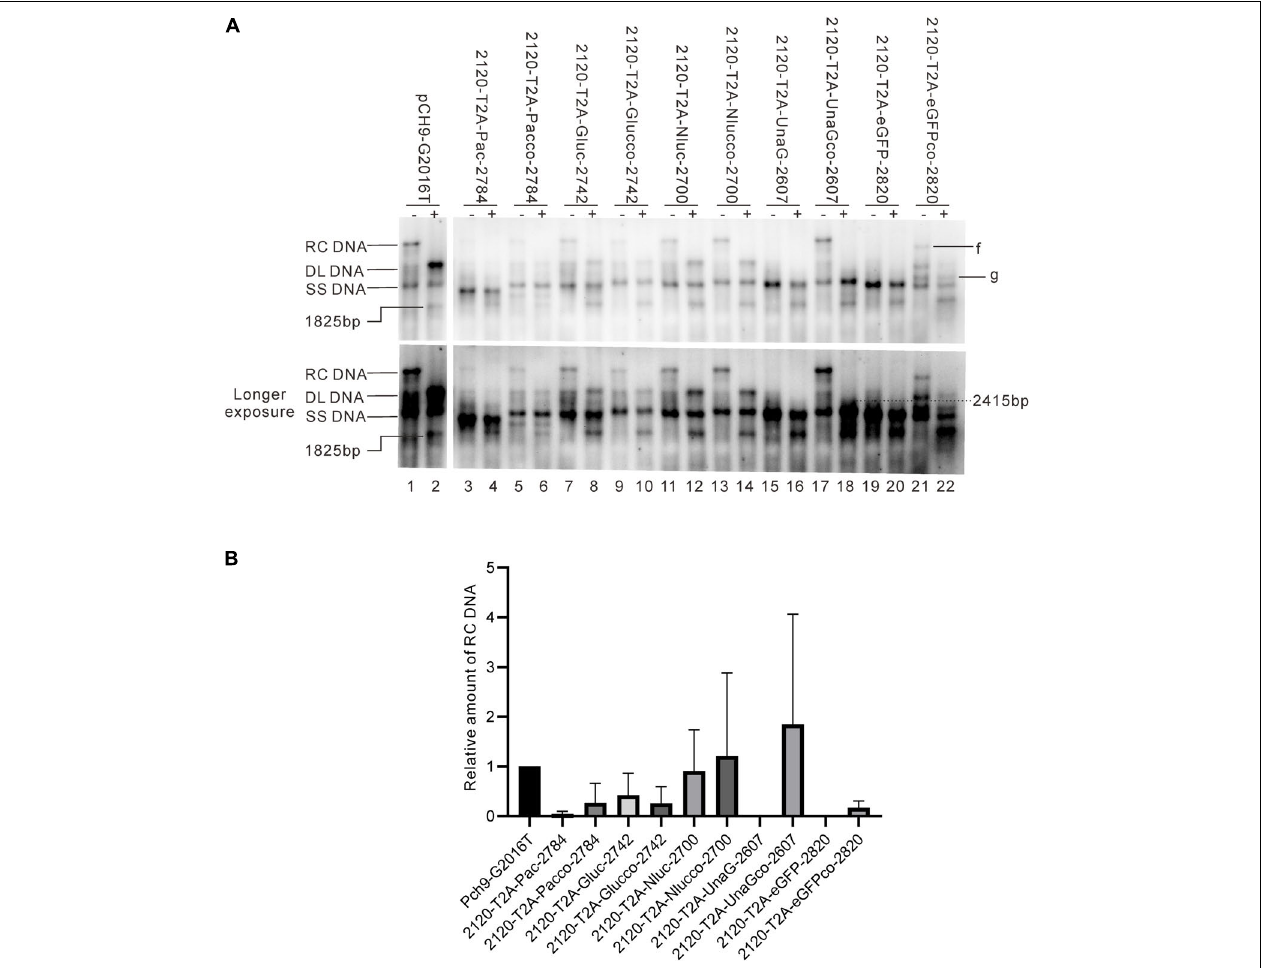
FIGURE 9 | Influence of sequence optimization of exogenous genes on HBV replication. (A) A comparison of HBV DNA from the recombinants before and after sequence optimization. The plus sign (+) denotes Eco RI digestion. RC, DL, SS DNA, and Eco RI digested fragments are indicated. (B) The relative intensity of RC DNA. The intensity of each RC DNA was divided into the sum of RC DNA of all samples in the same membrane to calculate the relative intensity of RC DNA of each sample. N =